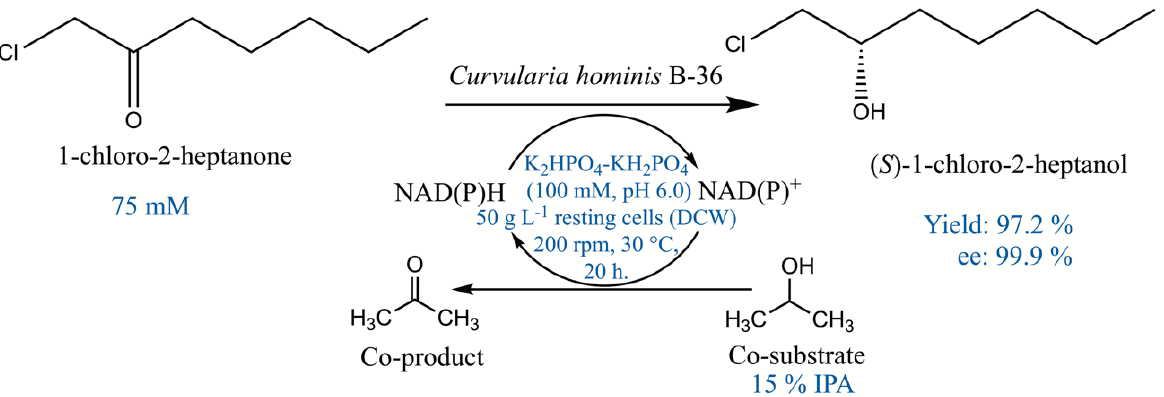
Figure 6. Time course of asymmetric biosynthesis of ( S )-1-chloro-2-heptanol. Reaction conditions: 20.0 mL K 2 HPO 4 -KH 2 PO 4 (100 mM, pH 6.0), 1.0 g resting cells (DCW), 50 mM 1-chloro-2-heptanone, 15% ( v/v ) IPA, 200 rpm, 30 °C.